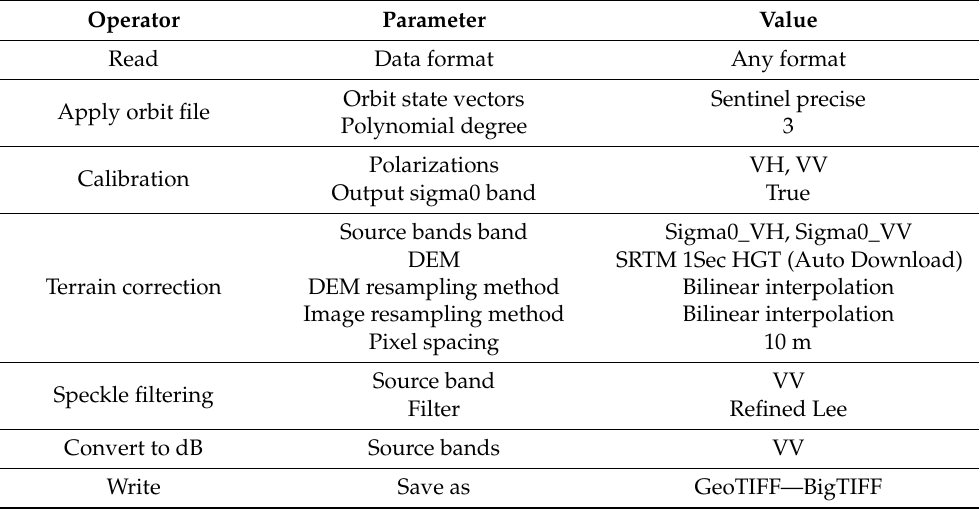
Table 3. List of the main parameters used in SNAP pre-processor module to process Sentinel-1 SAR